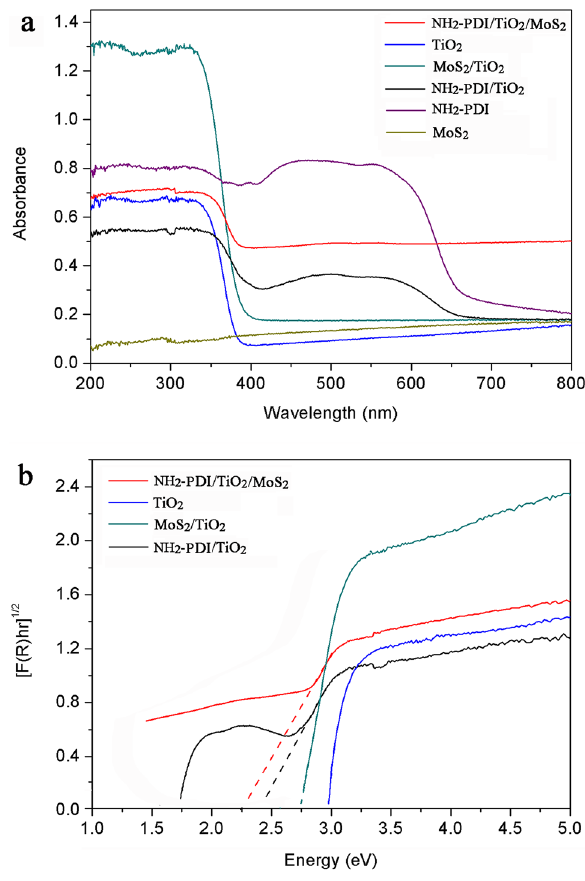
Figure 6. ( a ) UV–vis diffuse reflection spectra (DRS) and ( b ) The corresponding Tauc plot of